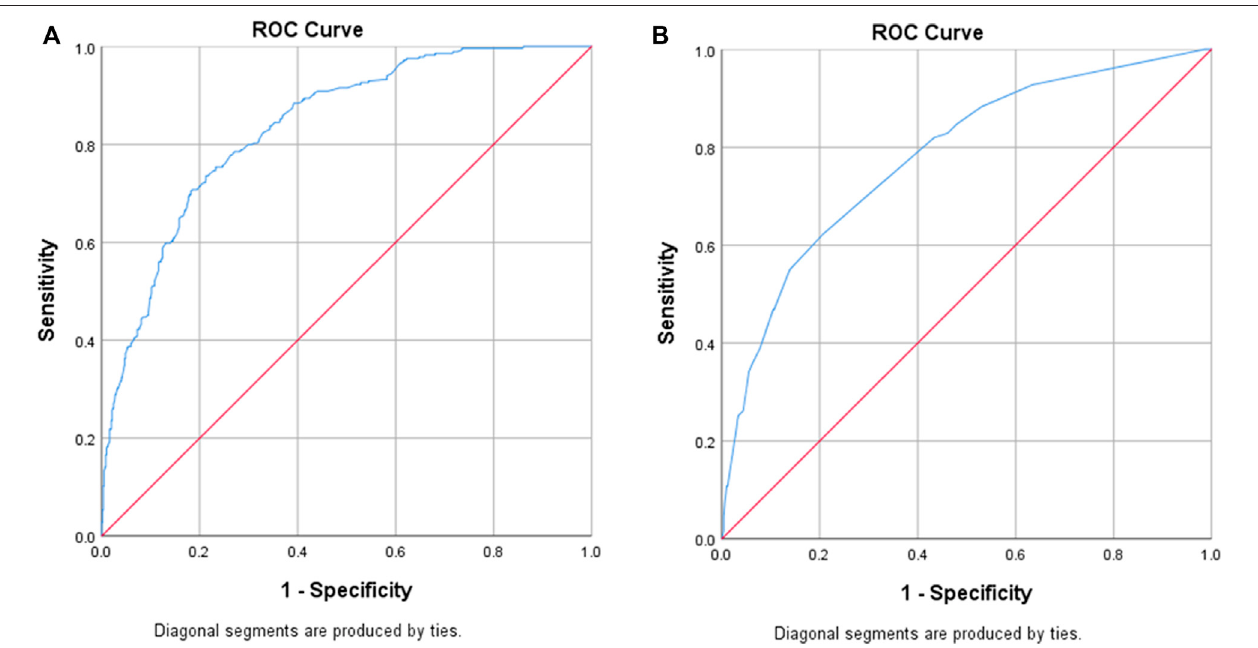
FIGURE 2 | Receiver Operating Characteristic (ROC) curves for each model. (A) ED Presentation screening tool: AUC of ROC curve = 0.84 (95% CI = 0.81 – 0.86), [sensitivity 80%, speci fi city 70%]. (B) ED Discharge screening tool: AUC of ROC curve = 0.78 (95% CI =0.73 – 0.83), [sensitivity 82%, speci fi city 57%]